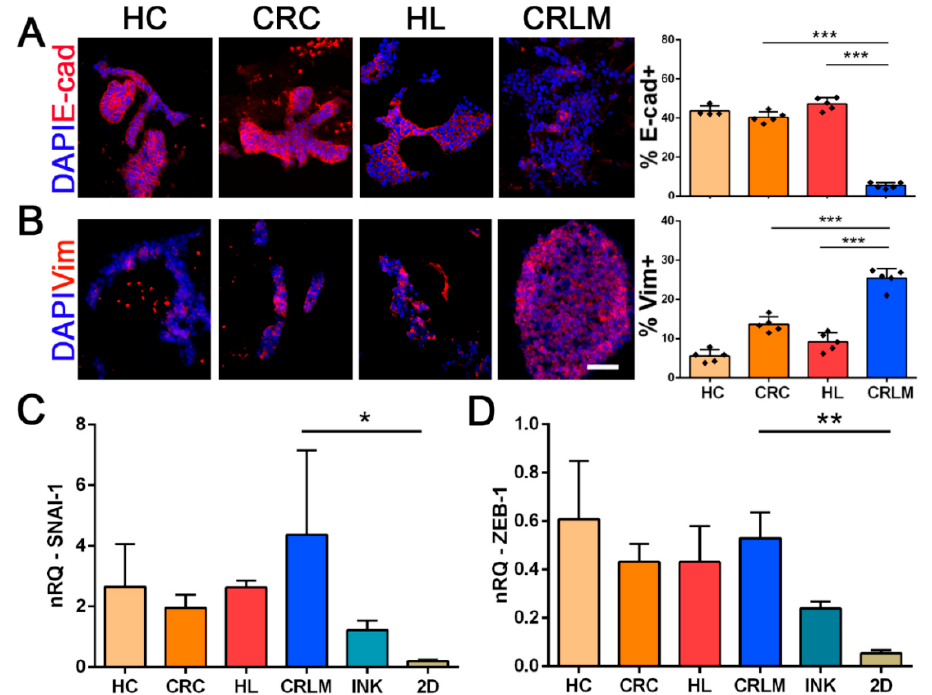
Figure 4. Phenotypic and molecular comparison of EMT markers between recellularized scaffolds and HT-29 cells cultured in 2D. Immunofluorescence images and quantifications at day 10 of ( A ) E-cadherin + and ( B ) Vimentin + ; nuclei were counterstained with DAPI (blue). ( C ) and ( D ) Gene expression level, after 10 days of culture, of SNAI-1 and ZEB-1 HT-29 ZsGreen/Luc + cells, respectively, seeded in HC, CRC, HL, CRLM, 3D-bioprintable ink (INK), and a conventional plastic plate (2D). Scale bar: 50 µm. Nrq = normalized relative quantity for qRT-PCR data. Graph bars, * p -value < 0.05; ** p -value < 0.01; and *** p -value < 0.001 by a one-way ANOVA test following Tukey’s Multiple Comparison